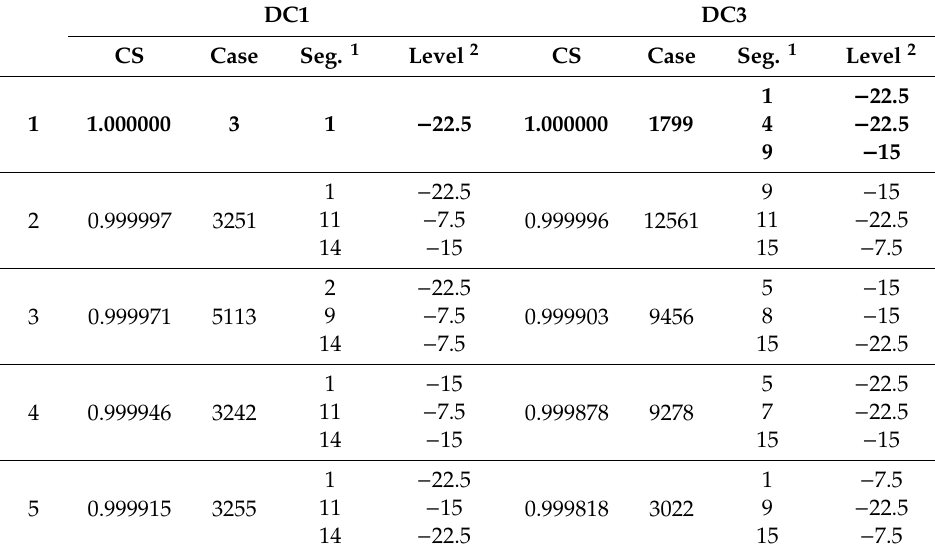
Table 4. Damage cases ranked in the top five and the corresponding cosine similarities of the independently updated baseline